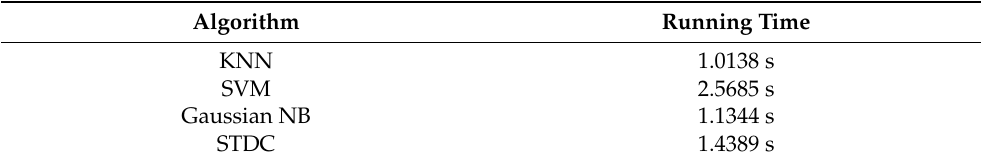
Figure 8. Comparison of the confusion matrix of the four algorithms. Each algorithm is tested 100 times and calculated the average running time. The results are shown in Table 5. Table 5. The average execution time.